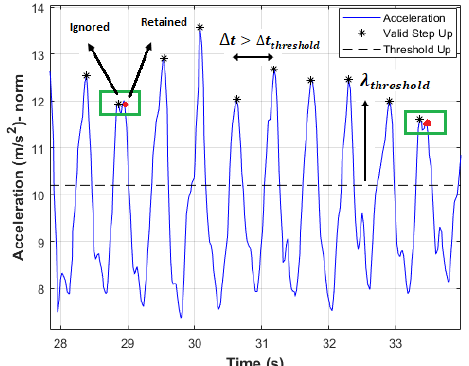
Figure 5. Detection of the valid steps for Holding